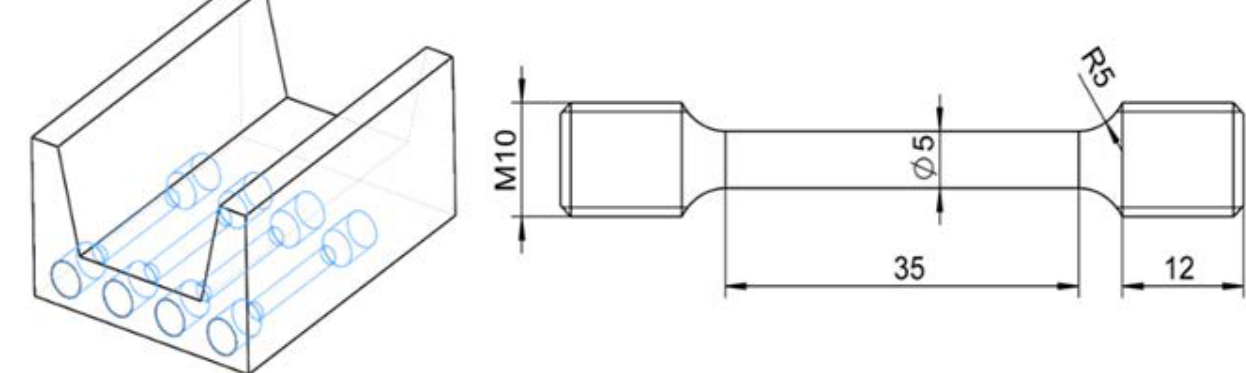
Figure 3. Schematic of uniaxial tensile test specimen (mm).